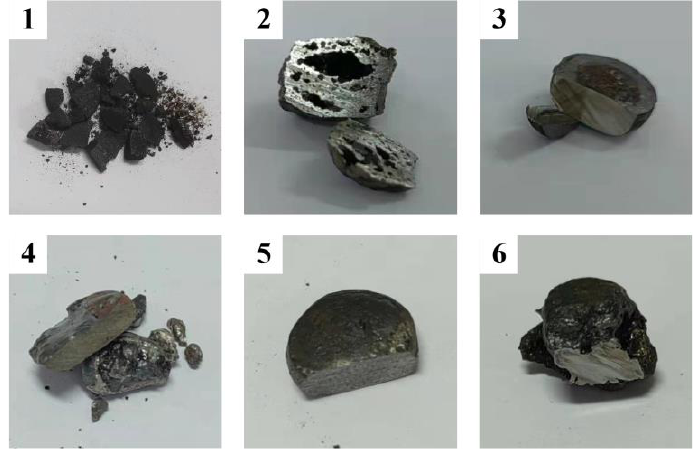
Figure 3. Appearance of the alloy after reduction: ( 1 ) 1250 °C, 13% C; ( 2 ) 1350 °C, 13% C; ( 3 ) 1450 °C, 13% C; ( 4 ) 1400 °C, 10% C; ( 5 ) 1400 °C, 13% C; ( 6 ) 1400 °C, 16% C.